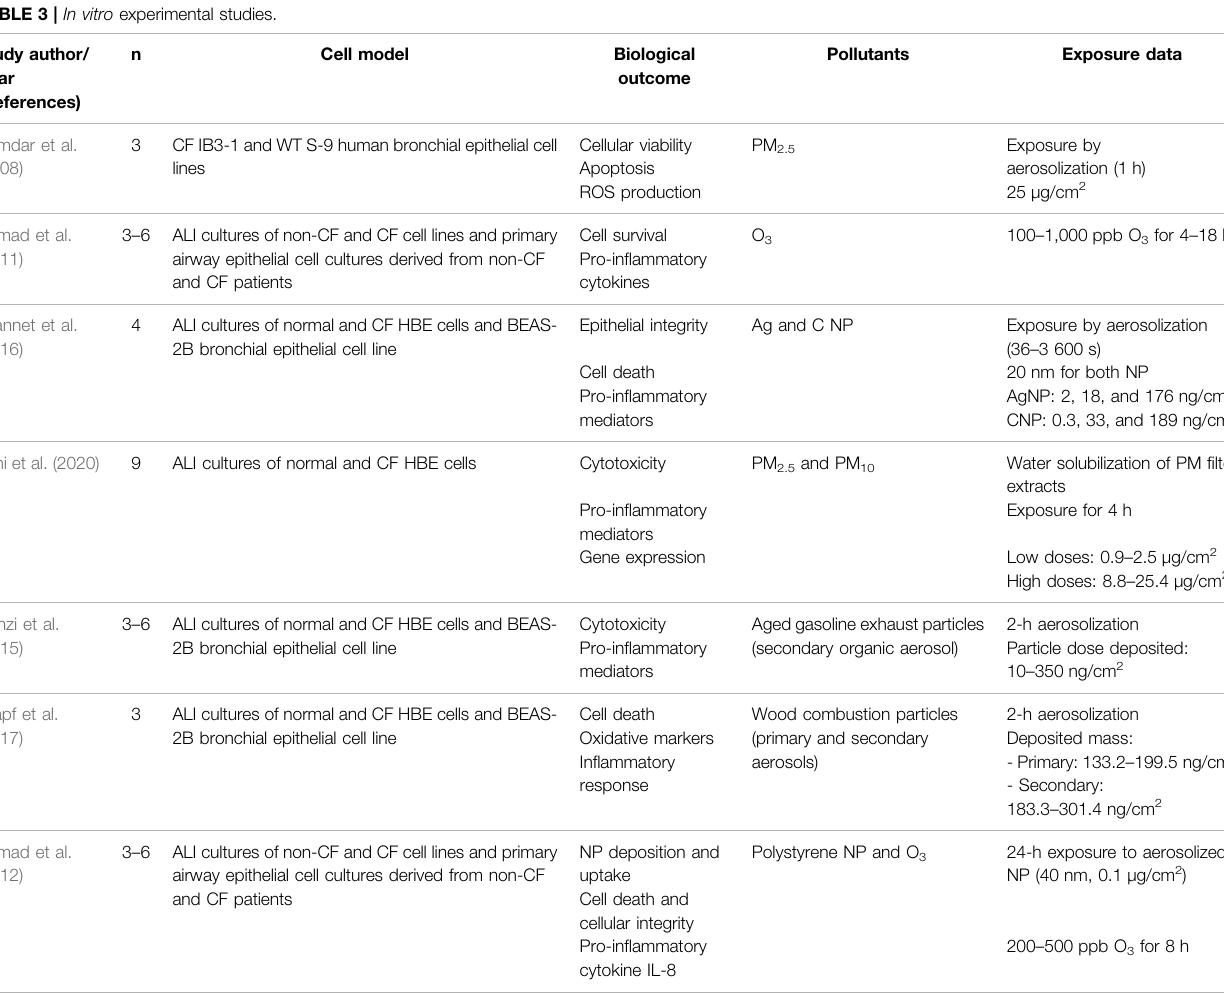
TABLE 3 | In vitro experimental